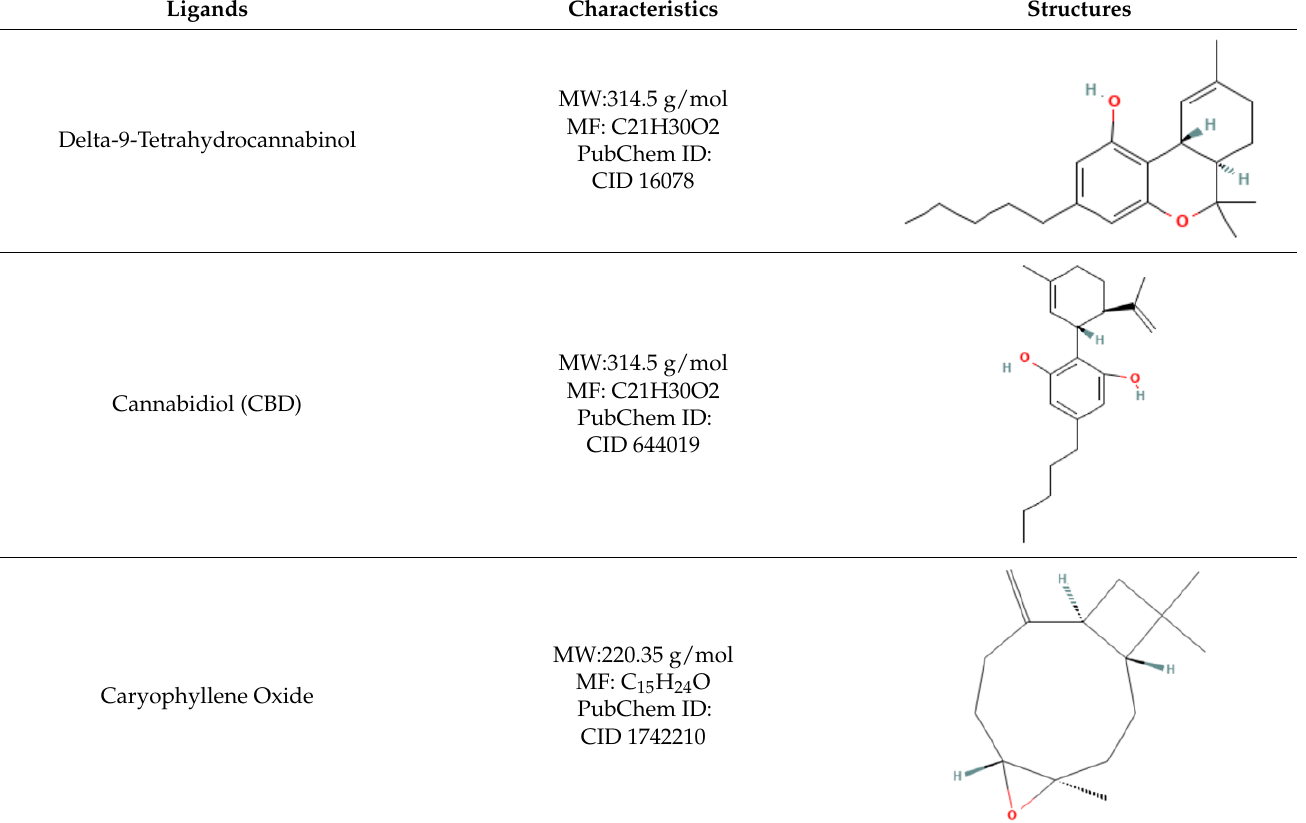
Table 1. Selected phytochemical compounds characteristics of C. sativa . Ligands Characteristics Ligands